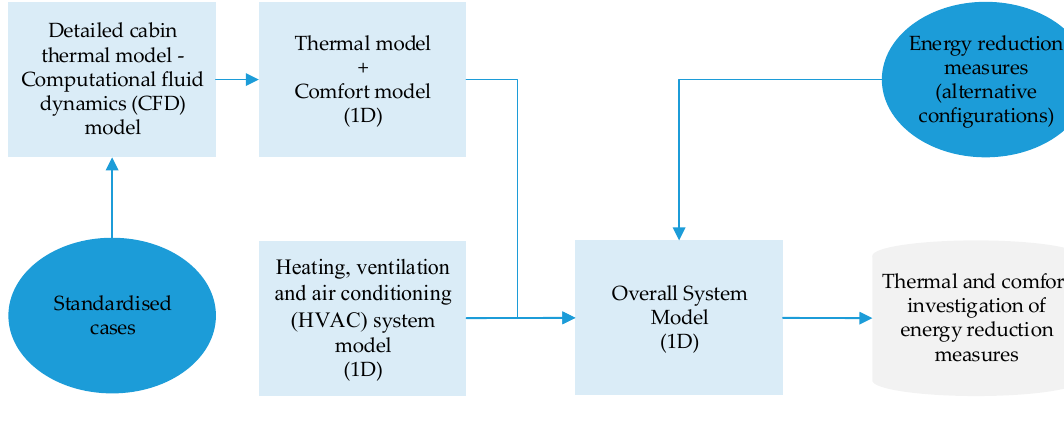
Figure 2. Methodology flow chart. Table 1. Standardised heating and cooling cases for the 1D thermal and comfort model.